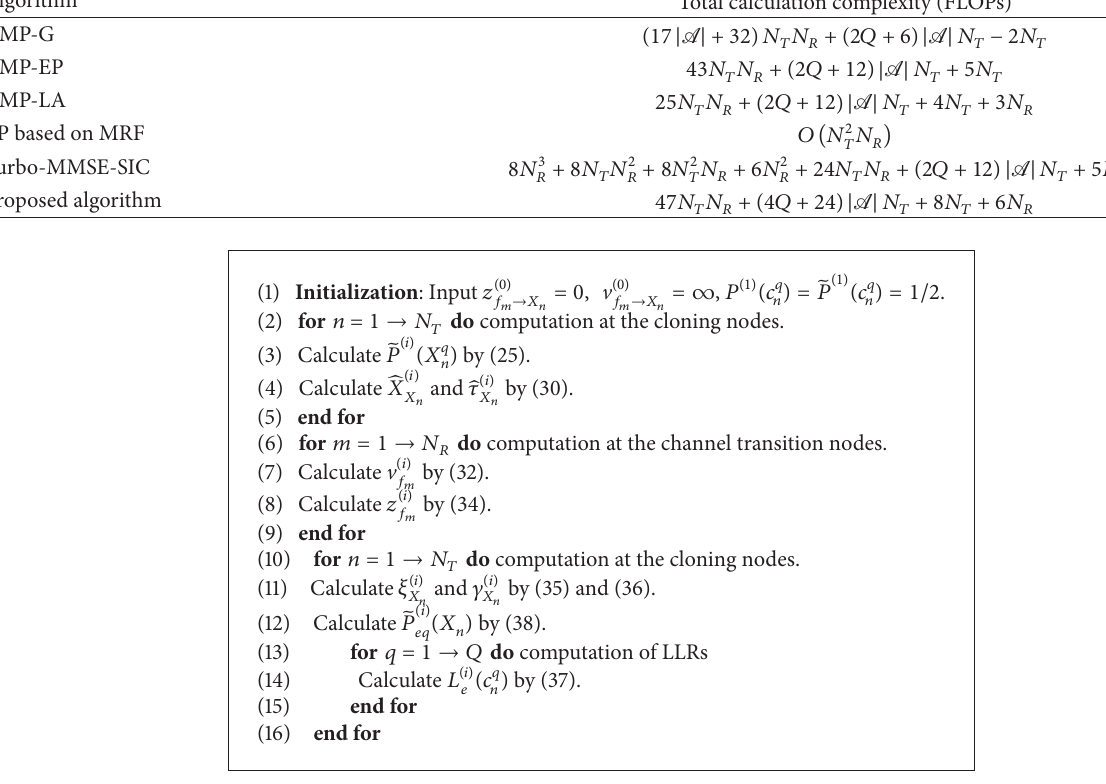
Algorithm 1: Processing procedure of the AMP-LA algorithm.